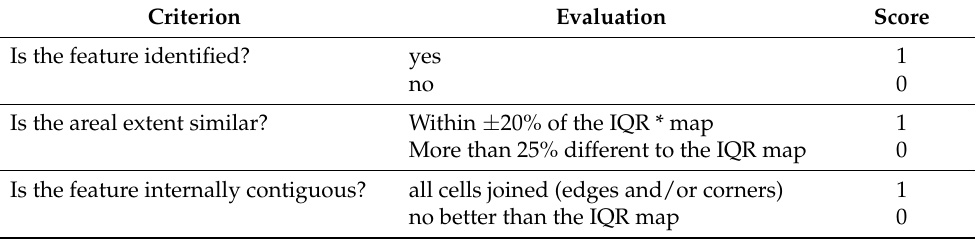
Table 4. Procedure used by an expert panel to rate each cluster map. Binary scoring (yes or no) for each identified feature was designed to discourage any assessment subjectivity. Criterion Evaluation Score Is the feature identified? yes 1 Within ± 20% of the IQR * map